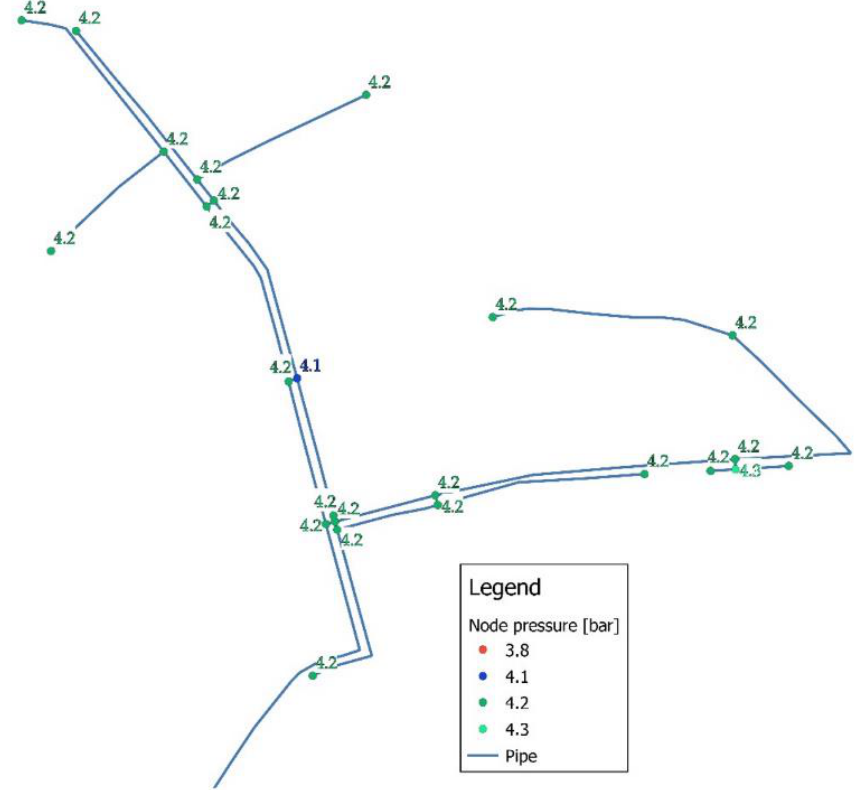
Figure 6. Hydraulic model maximal pressures in every node.